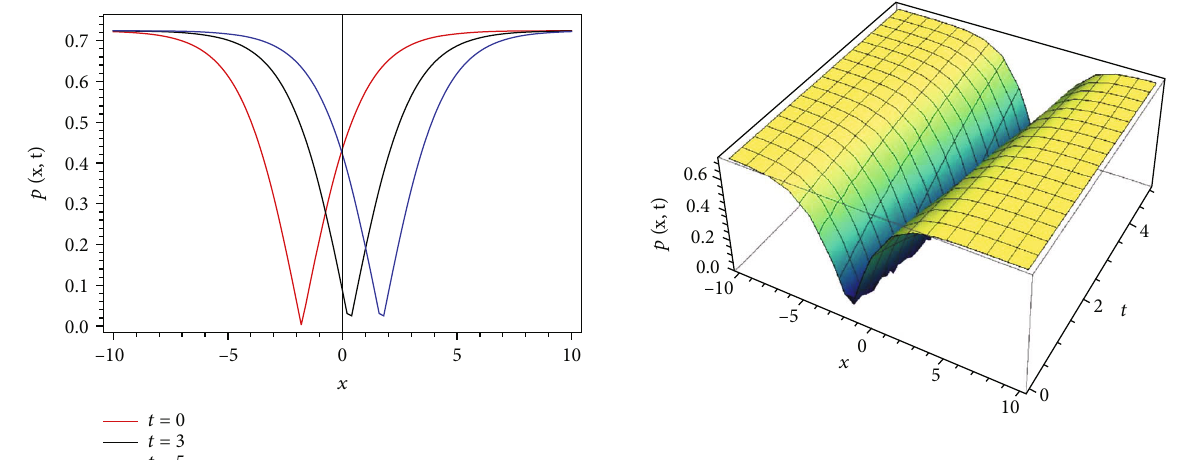
: 2, β : 7, γ : 2, k = 0 : 4, α = 0 : 7, λ = 1, μ = 0 : 1, h j = 0 j = 0 j = 0